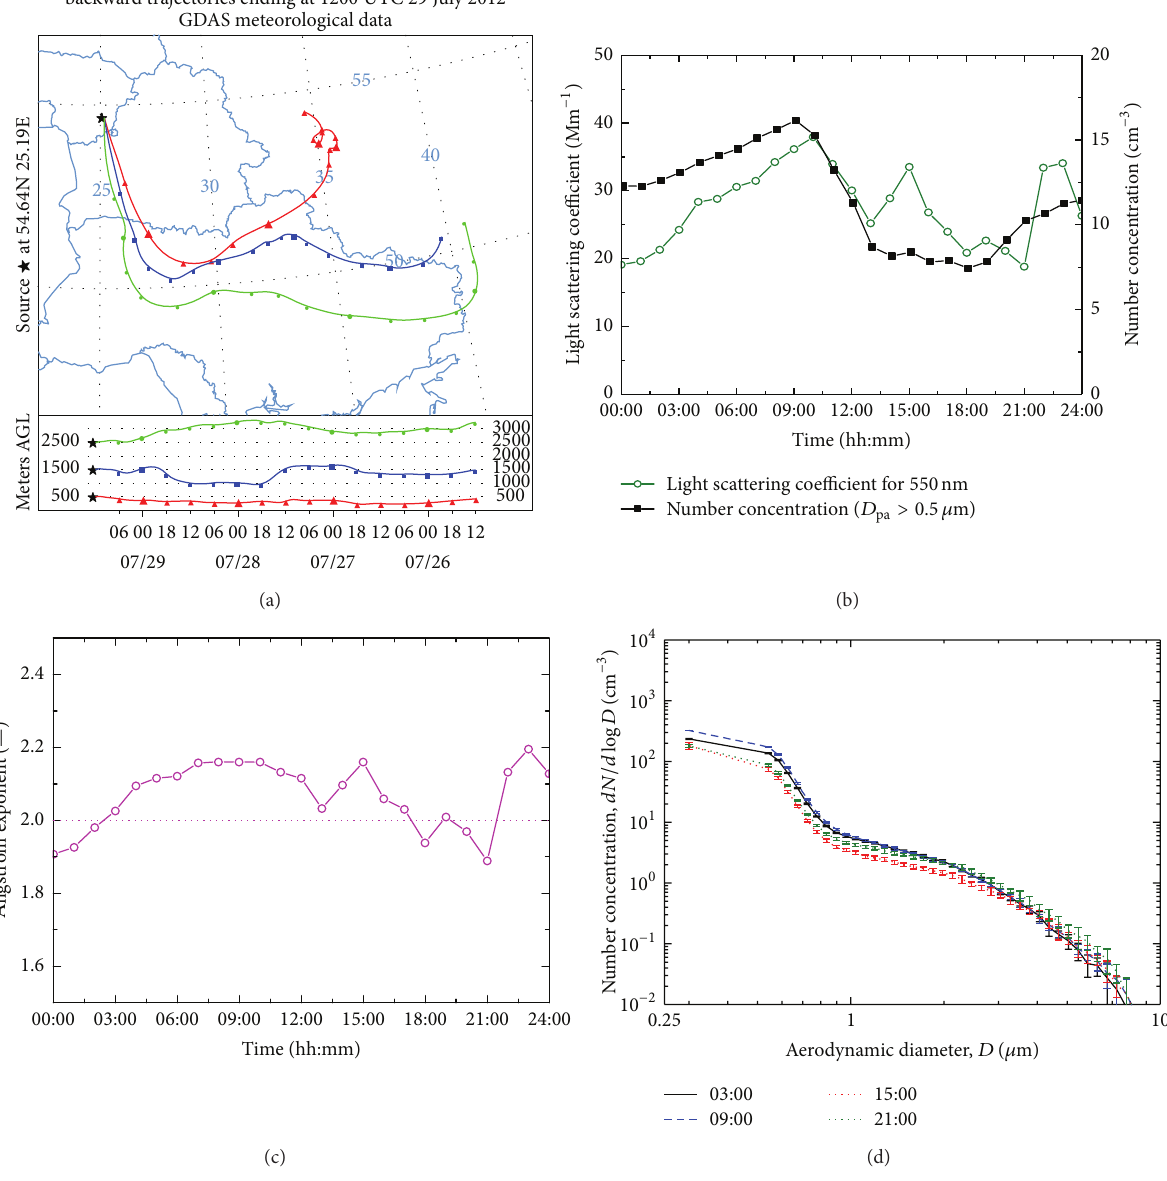
Figure 4: (a) Air parcel trajectory analysis from the National Oceanic and Atmospheric Administration (NOAA) Air Resources Laboratory (ARL) HYSPLIT model. For this analysis, the model was run backwards for 96 hours from 29th July 2012 at 12 UTC. Traces show the origin of air parcels at Vilnius at the 500 m (red), 1500 m (blue), and 2500 m (green) levels. (b) The variation of the measured and hourly averaged values of the light scattering coefficient at 550 nm and the particle number concentration. (c) The calculated ˚Angstr¨om exponent for 450 and 700 nm wavelength pair. (d) The particle size